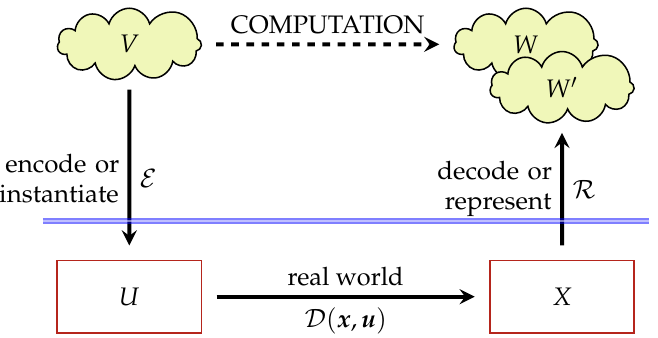
Figure 6. Computing with dynamical systems adapted from [72]. Conceptual depiction of the sets and transformations involved in a typical computation using a dynamical system the computation is defined by its action on the input-output set V , W . The inputs u ( t ) encoded or instantiated versions of V through the transformation system x ( t ) X is decoded or represented back into the set W 0 via the readout transformation ∈ W and W 0 are similar, the composed transformation